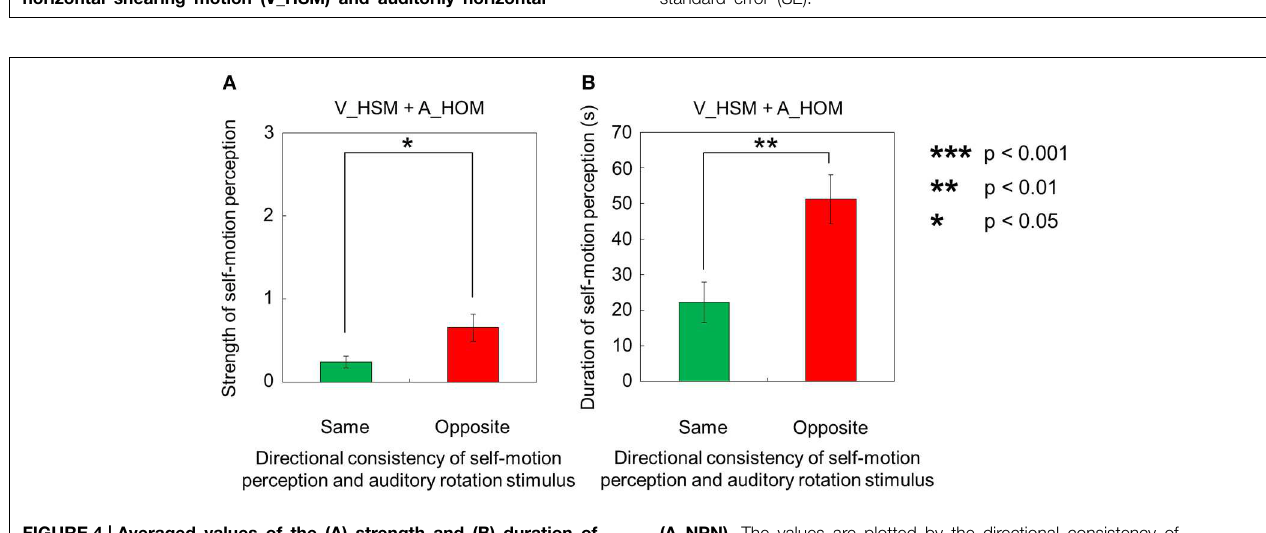
FIGURE 3 | Averaged values of the (A) strength and (B) duration of self-motion perception in the condition combining visually horizontal shearing motion (V_HSM) and auditorily horizontal